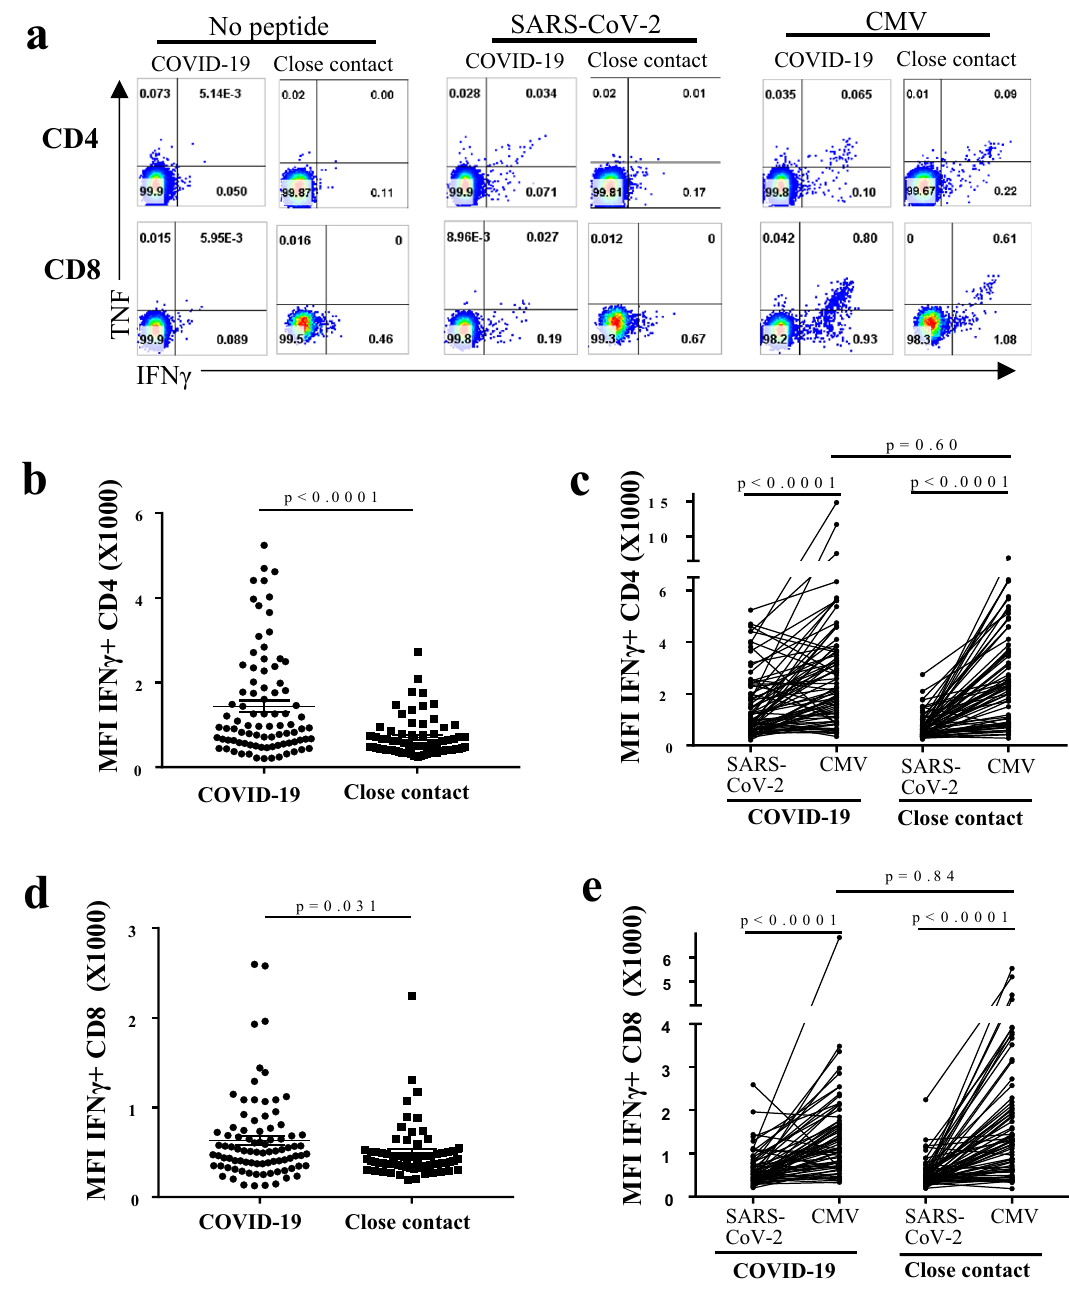
Fig. 2 Functional analysis of SARS-CoV-2 speci fi c memory T cells in Covid-19 patients and close contacts. Donor PBMCs were stimulated with SARS- CoV-2 or CMV 15-mer peptide pools overnight in the presence of 10 U/ml rIL-2, IFN γ and TNF expressing cells were enumerated by intracellular cytokine staining. a Representative FACS plots showing the expression of IFN γ and TNF in CD4 + and CD8 + T cells with or without SARS-CoV-2 or CMV peptide stimulation overnight, as indicated. b , d Mean Fluorescence Intensity (MFI) of IFN γ staining for ( b ) CD4 + and ( d ) CD8 + T cells from COVID-19 patients (close circle, n = 89) and their close contacts (closed square, n = 69) after overnight stimulation with SARS-CoV-2 peptide pool. c , e Paired analyses of MFI for IFN γ of CD4 + ( c ) and CD8 + ( e ) T cells after overnight stimulation with SARS-CoV-2 or CMV peptide pools for COVID-19 patients ( n = 79) and close contacts ( n = 69). Each symbol represents a data point from one individual. b – e Error bars represent mean ± SEM. The student t test was performed with two-sided p values as indicated. No peptides: no peptide stimulation control. SARS-CoV-2: with stimulation by SARS-CoV-2 overlapping peptide pools. CMV: with stimulation by CMV overlapping peptide asymptomatic patients, respectively, proliferated to detectable levels (Fig. 3e), respectively. Thus, there was no signi fi cant difference in (Fig. 3f). For the CD4 + T cells, 97.22% and 83.33% of the samples the qualities of the memory T cells between the asymptomatic and symptomatic patients ( p = 0.39 for CD4 + and p = 0.44 for from the symptomatic and asymptomatic patients, respectively, CD8 + , Fig. 3b, e). proliferated to levels above 1% (Fig. 3c). This indicates a slightly reduced proliferation capacity in SARS-CoV-2-speci fi c T-cell In vitro peptide stimulation and expansion showed that 88.89% immunity of asymptomatic patients ( p < 0.0001, Fig. 3c). and 72.22% of CD8 + T cells from the symptomatic and